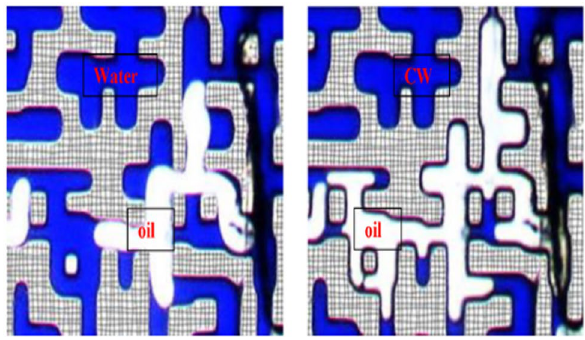
Fig. 3 Comparison of the oil volume before and after CWI. Image analysis observed that a massive 105% oil swelling was captured by image analysis (Sohrabi et al.